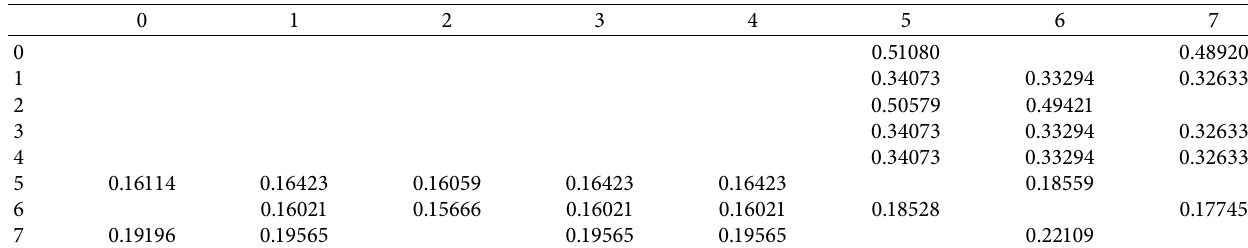
Table 11: Initial spread probability of each infected